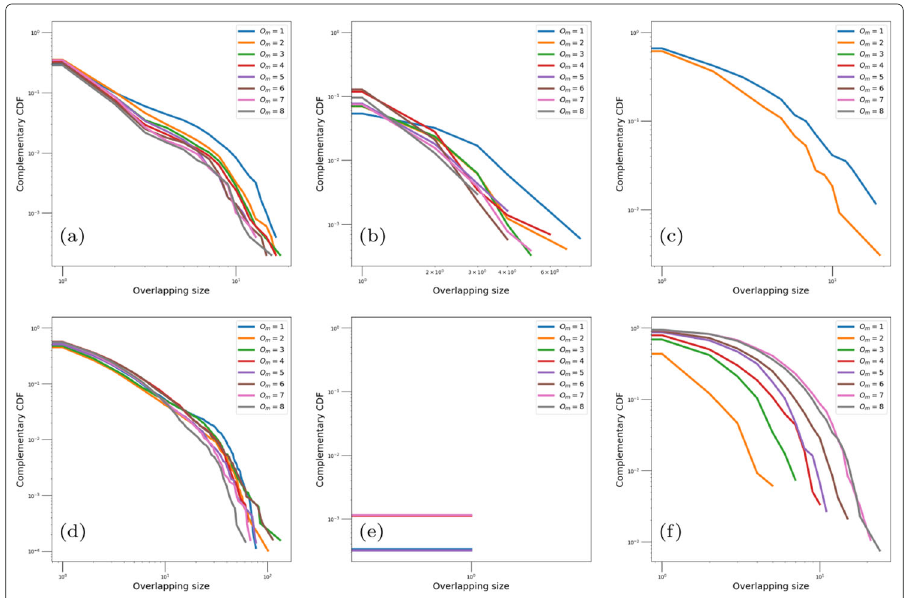
Fig. 3 Variation of the maximum number of memberships ( O m ) for LFR synthetic networks considering the overlapping size: a Bigclam; b CFinder; c Copra; d Demon; e SLPA; f